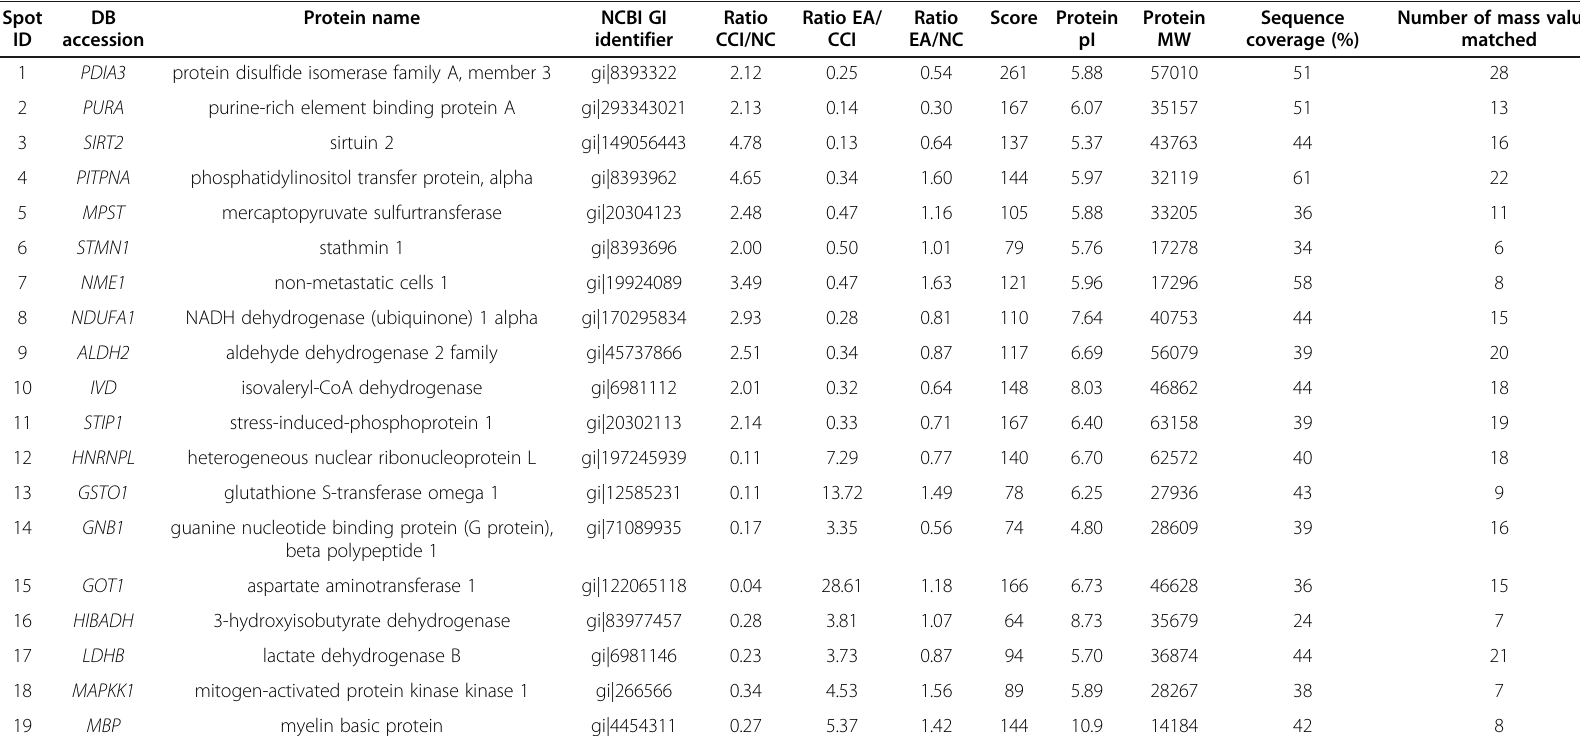
Table 1 List of hippocampal differentially expressed proteins after